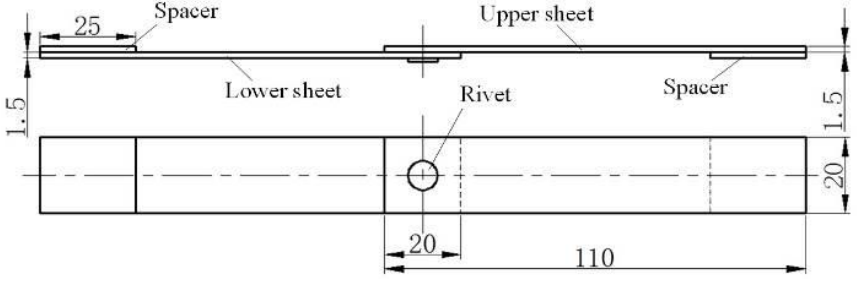
Figure 2. Specimen geometry (dimensions in mm).